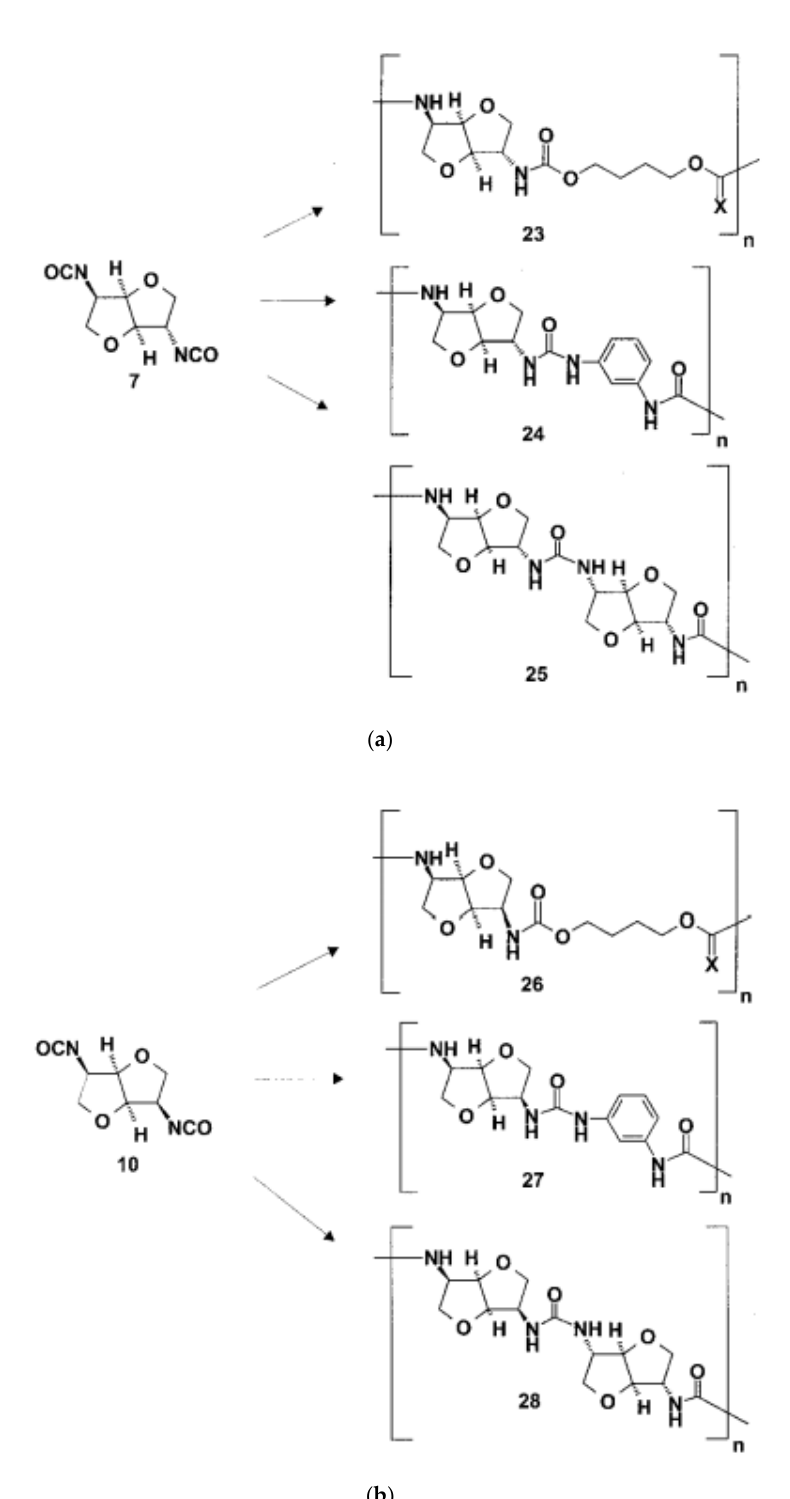
Figure 28. ( a ) Synthesis of polyurethane and of polyureas from the D-gluco monomers 7. From reference [57]. ( b ) Synthesis of polyurethane and of polyureas from the D-manno monomers 10. From reference [57].